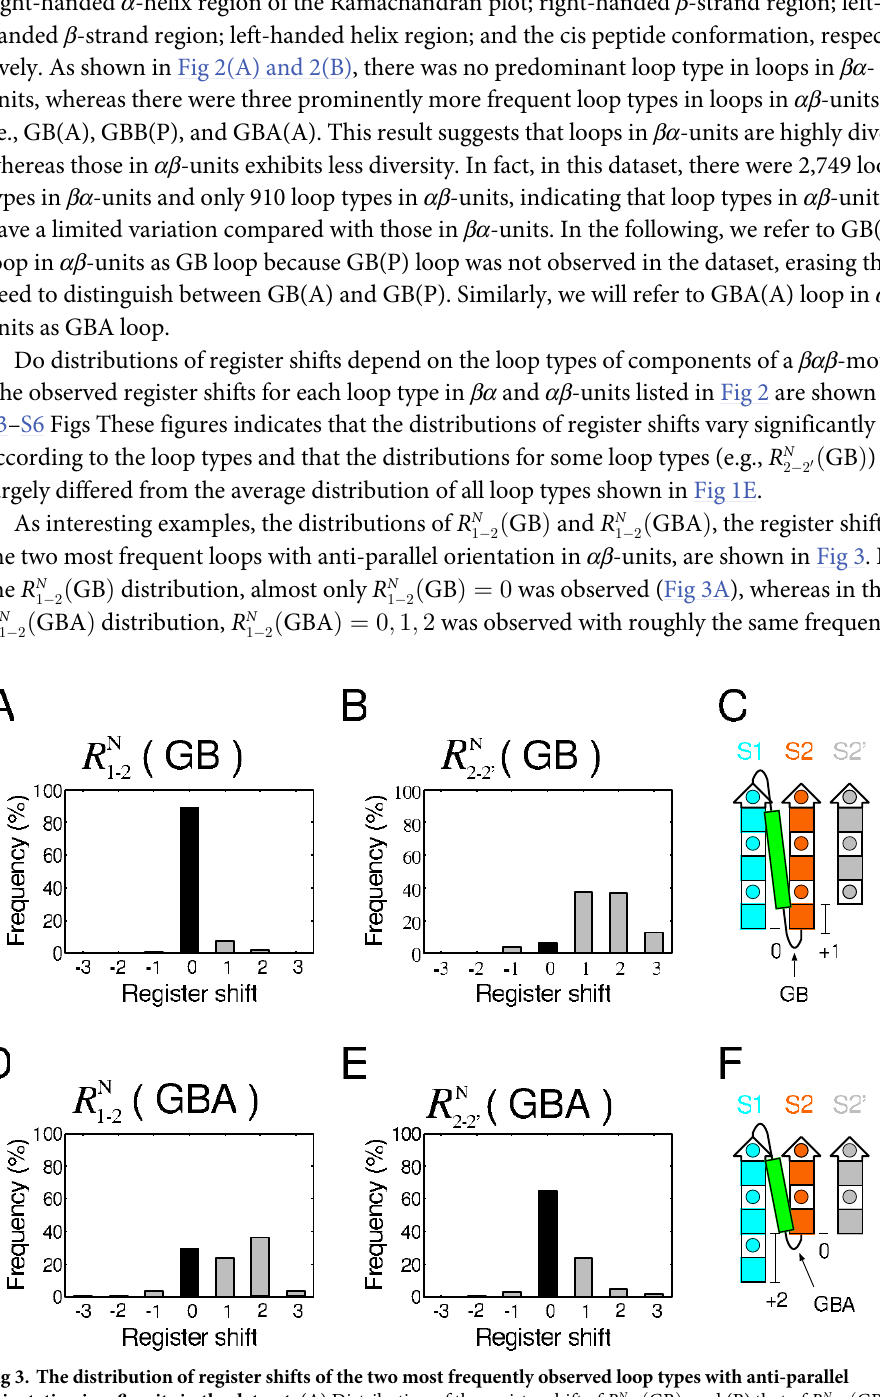
ð GB Þ , and (B) that of R N ð GB Þ . 1 (cid:0) 2 2 (cid:0) 2 0 ð GB Þ and R N ð GB Þ . (D) 1 (cid:0) 2 2 (cid:0) 2 0 ð GBA Þ , and (E) that of R N ð GBA Þ . (F) Schematic structure of a βαβ -motif with 1 (cid:0) 2 2 (cid:0) 2 0 ð GBA Þ and R N ð GBA Þ . In (C) and (F), the square with a circle inside represents 1 (cid:0) 2 2 (cid:0) 2 0